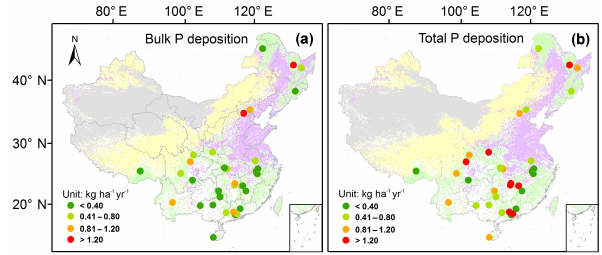
Figure 3. Spatial patterns of N:P ratios in (a) bulk precipitation (BP) and (b) throughfall (TF) in China’s forests. The background shading in light green, light yellow, light purple and light grey indi- cates the distribution of forest, grassland (semiarid region), cropland and non-vegetated land,